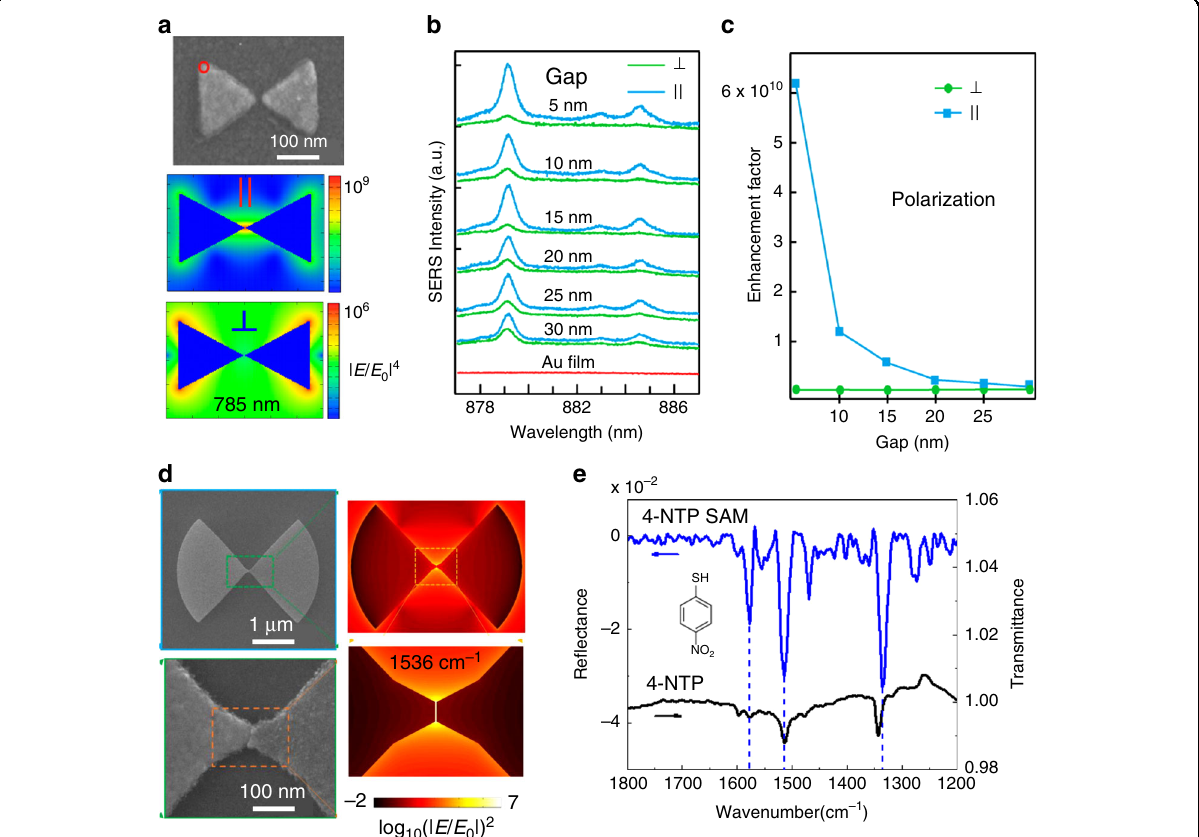
Fig. 5 Dimers for SERS and SEIRA. a SEM image of prism dimers and simulated electric fi eld contour plot of both polarizations. b SERS spectra of 2- naphthalenethiol SAM excited by 785 nm laser, and c SERS enhancement factor of prism dimers with varying gaps between prisms for both polarizations. Reproduced with permission from ref. 60 . Copyright (2013) American Chemical Society d SEM and simulated electric fi eld distribution of a bowtie antenna (at 1536 cm – 1 ). e SEIRA of 4-NTP SAM on a single antenna. Reference spectra of solid-state 4-NTP are shown in black with prominent vibrations indicated by dashed lines. Reproduced with permission from ref. 62 . Copyright (2017) American Chemical